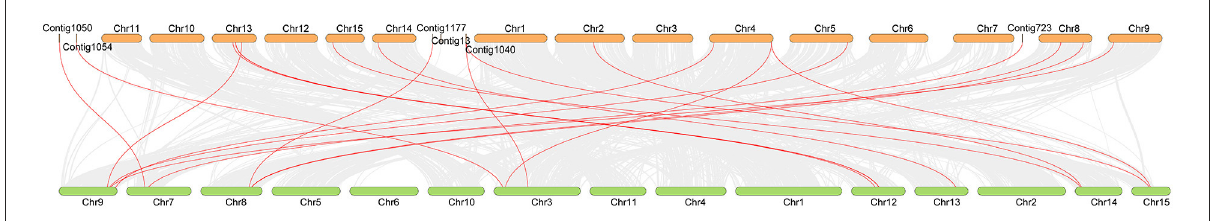
FIGURE4 The syntenic relationship of OVATE gene between cultivated tea tree and ancient tea tree. The red lines highlight the syntenic OVATE gene pairs. Orange and green represent “ShuChaZao” and “DASZ” genomes, respectively.